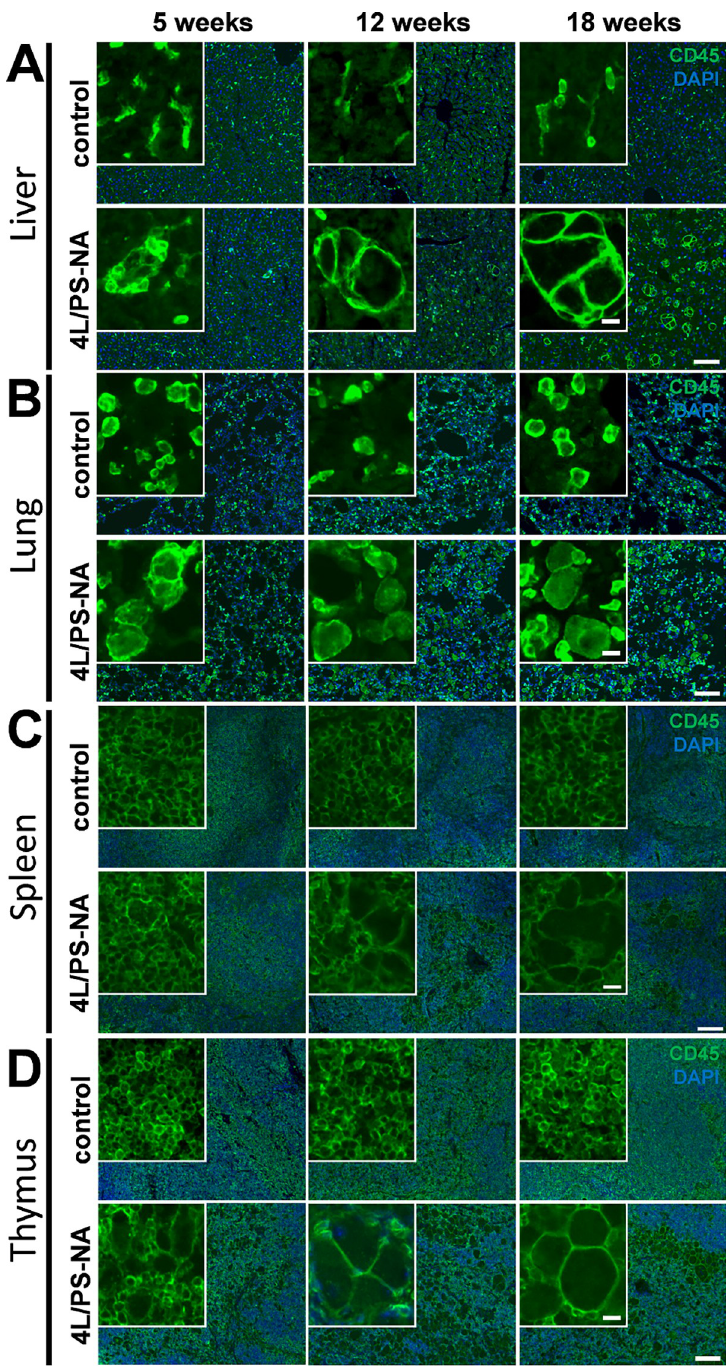
Fig 3. Enlarged leukocytes in visceral organs of 4L/PS-NA mice. The liver ( A ), lung ( B ), spleen ( C ) and thymus ( D ) of 4L/PS-NA mice and control littermates were labeled with CD45 antibody at the age of 5, 12 and 18 weeks; green: CD45; blue: DAPI. Scale bars: Overview: 100 μ m, inserts: 10 μ